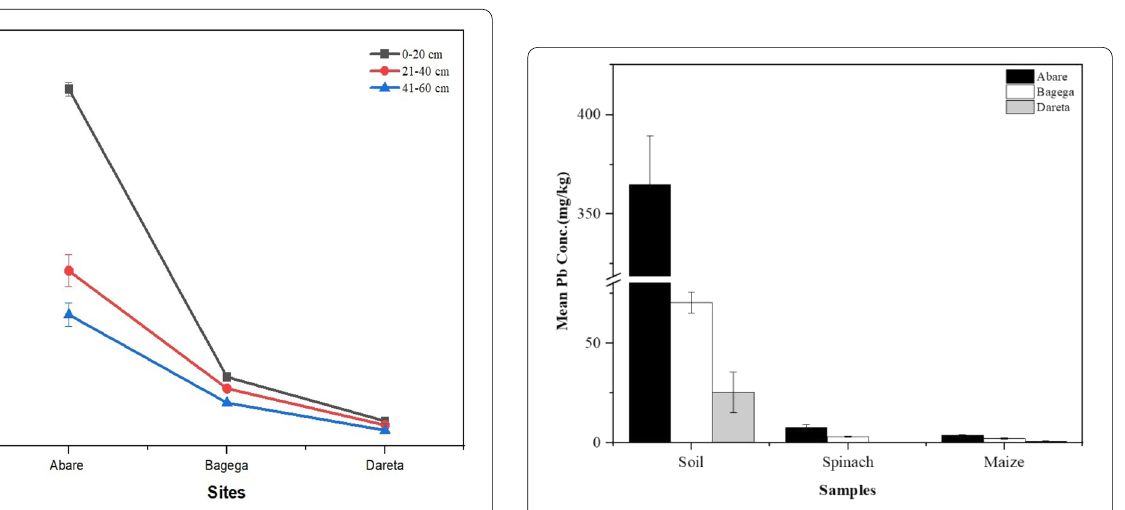
Fig. 3 Mean Pb Conc. (mg/kg) of soil, spinach and maize in the cultivated farmland of Anka local government, Zamfara state,